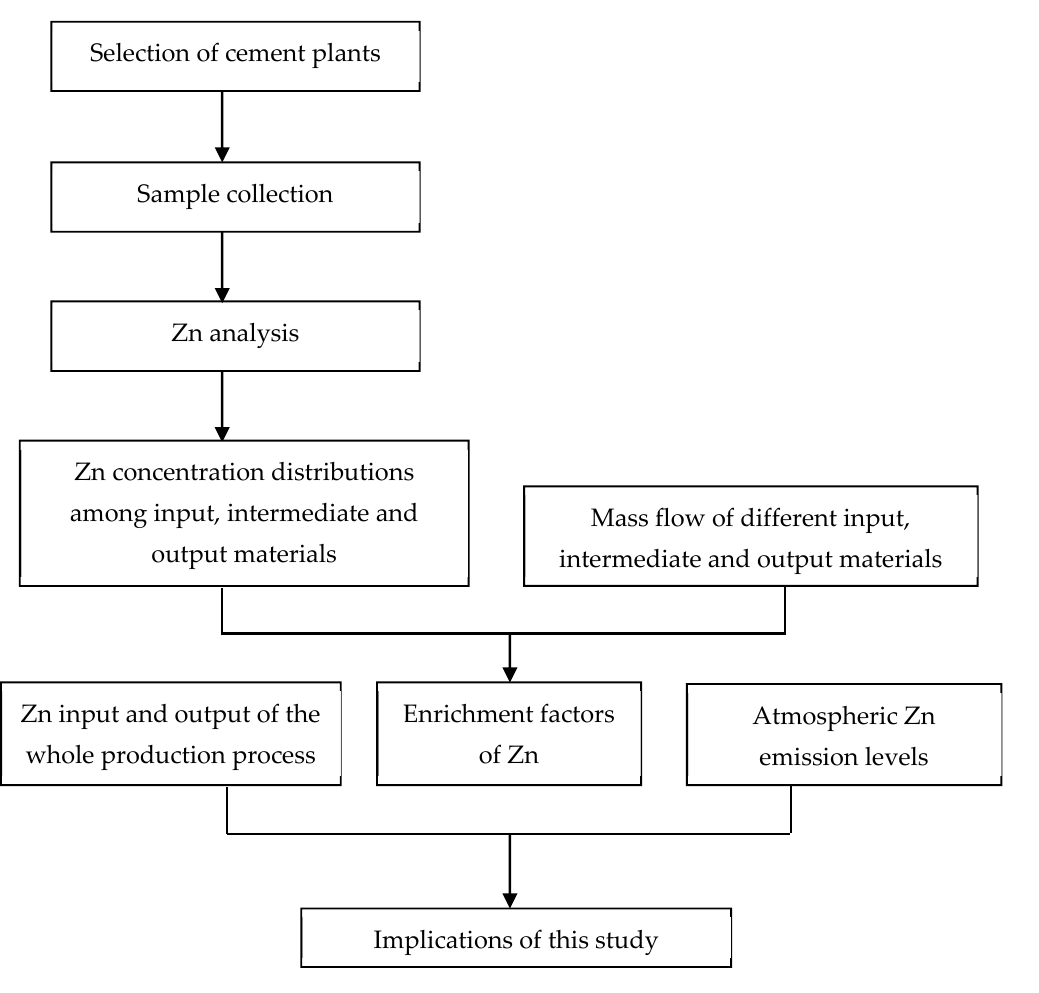
Figure A2. The research framework of this study. Table A1. Concentration of Zn in different solid materials during the clinker production process.